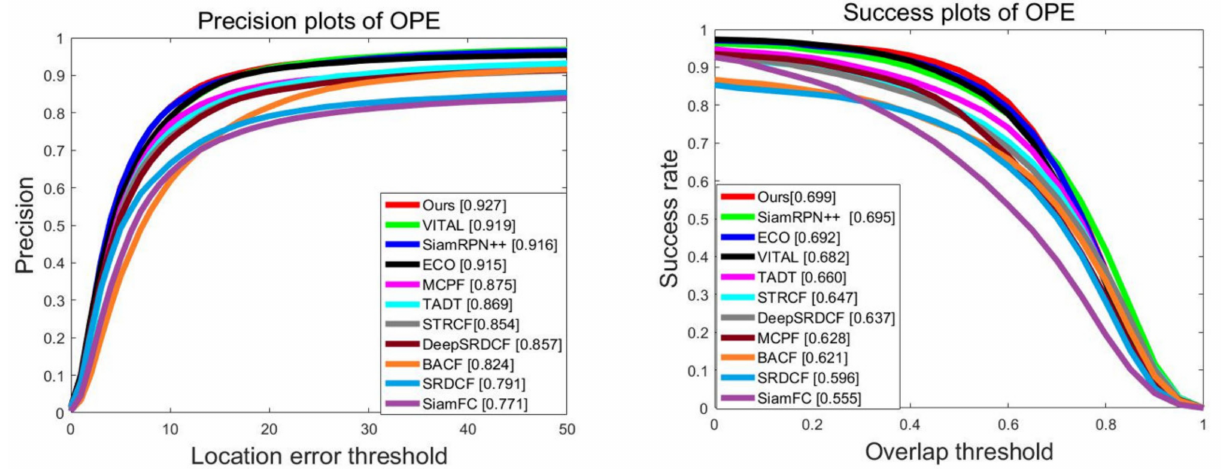
Figure 3. Overall precision plots and success plots of OPE evaluated on OTB2015.